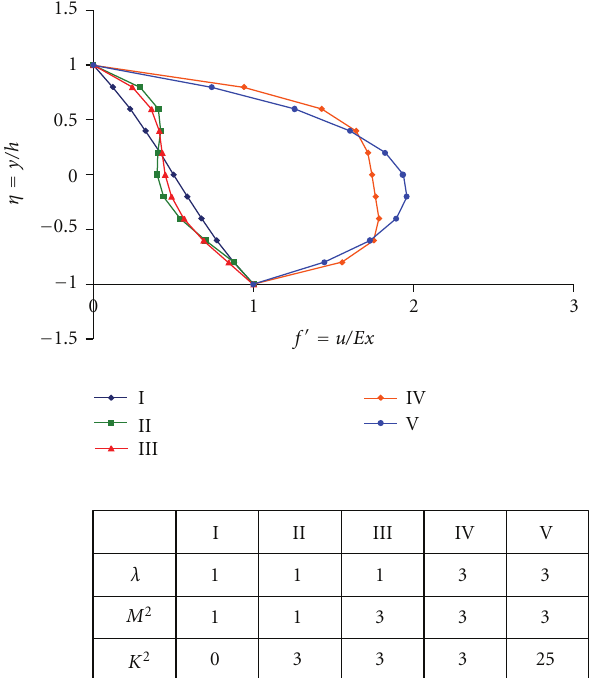
Figure 3: Velocity profile for f (cid:3) (cid:7) R (cid:6) 0 . 1 ,N (cid:6) 10 (cid:8)